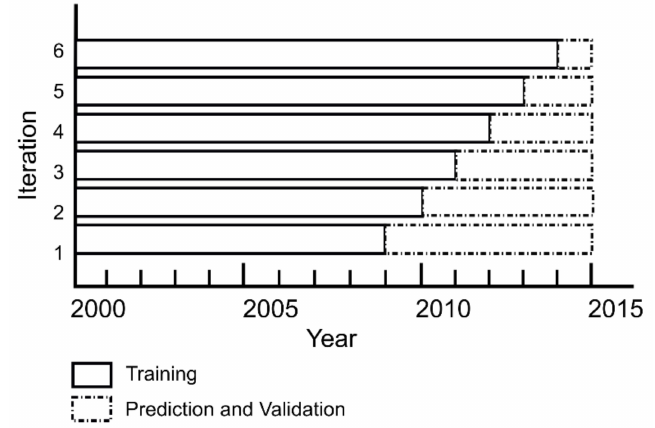
Figure 2. Unit-level model fitting process for fitting and selecting the final model, between three classes of models, used to predict short-term future BS population and future unit-average BS population density. Here we employ a rolling origin framework, with the final model selected based upon the smallest sum of the Median Absolute Percent Error